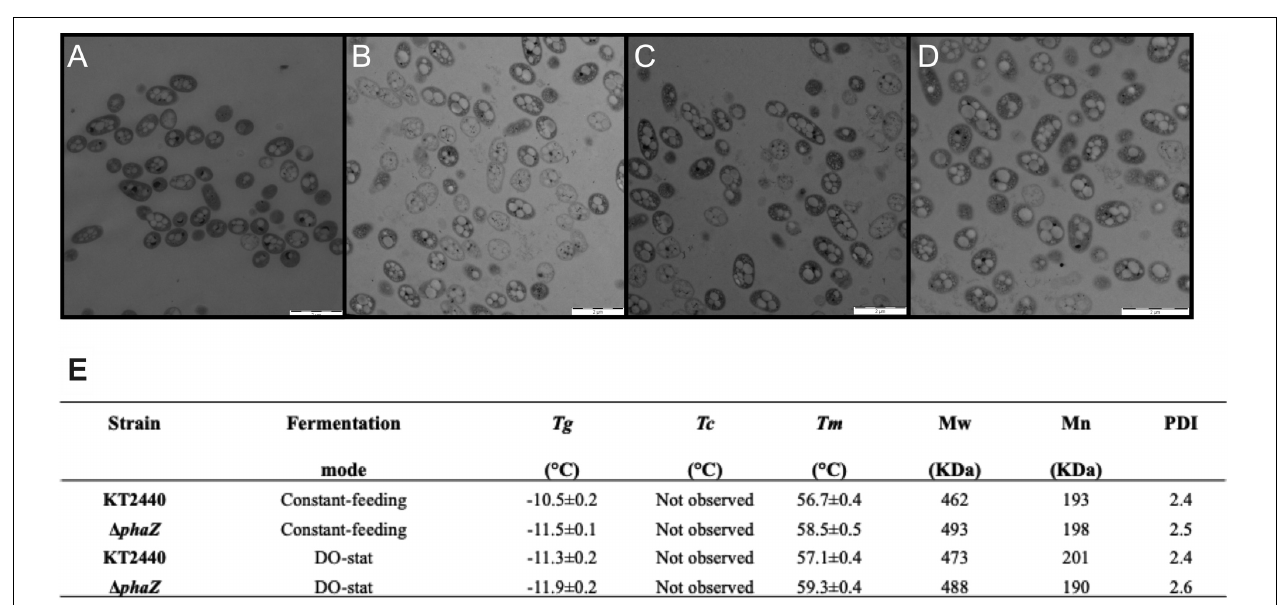
FIGURE 3 | Transmission electron micrographs of P. putida cells in fed-batch fermentation taken at 60 h fermentation. (A) P. putida KT2440 constant feeding, (B) phaZ -knockout mutant constant feeding, (C) P. putida KT2440 DO-stat, and (D) phaZ -knockout mutant DO-stat. (E) Thermal properties of the biosynthesized mcl -PHA: Transition glass temperature ( Tg ), melting temperature ( Tm ), and crystallization temperature ( Tc ). Molecular weight ( Mw ), average-number molecular weight ( Mn ), and polydispersity index (PDI). The values represent mean and standard deviation from two